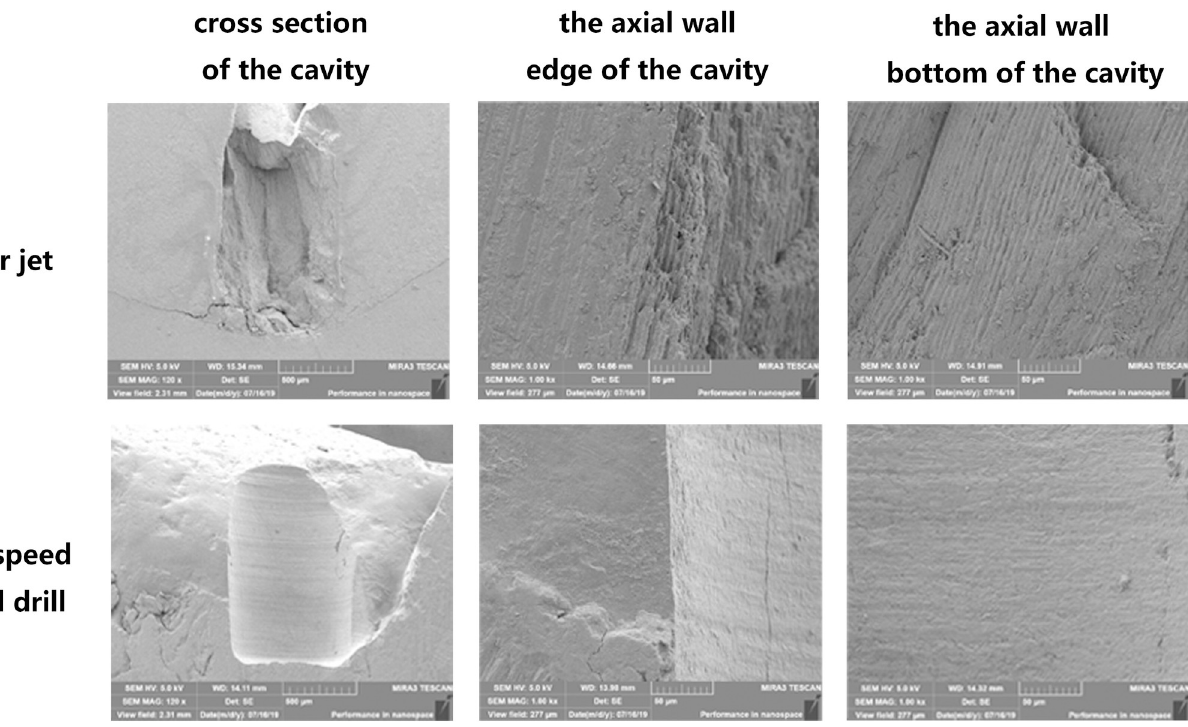
PLOS ONE | https://doi.org/10.1371/journal.pone.0254787 July 23,